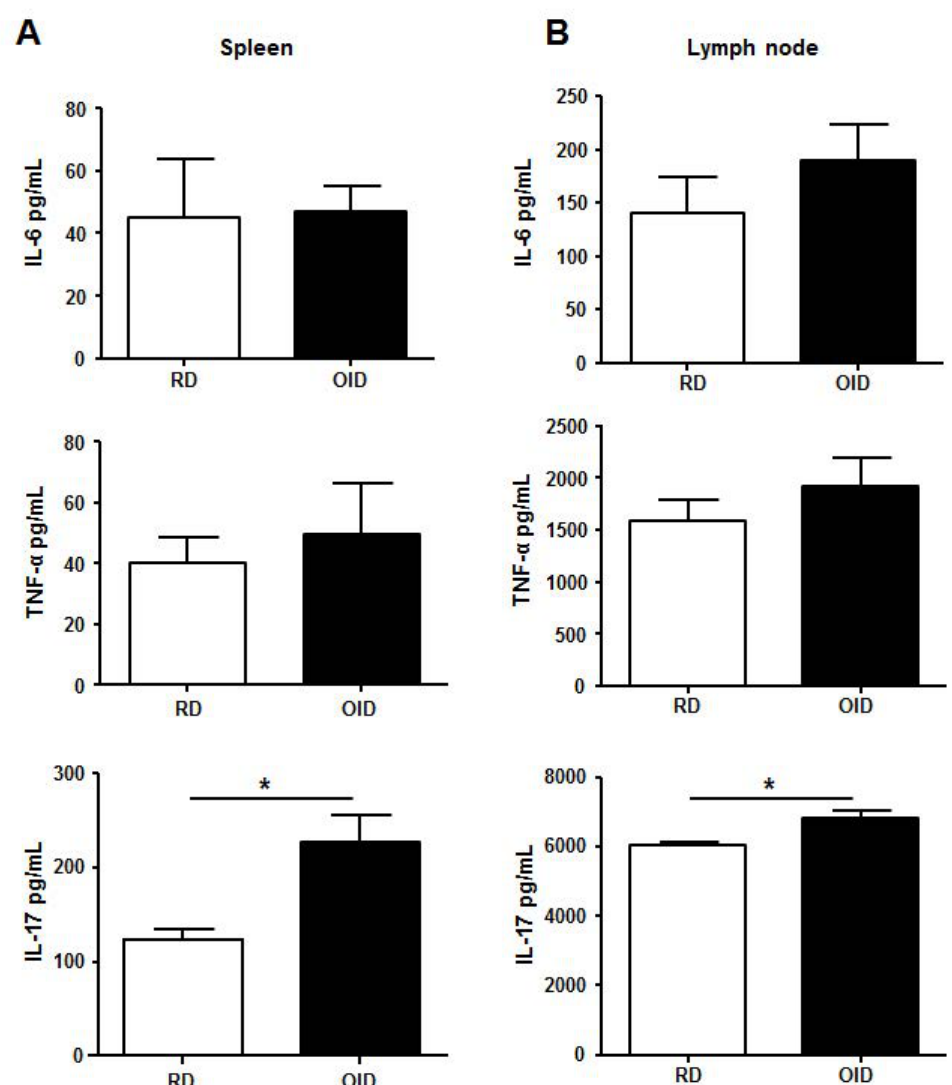
Figure 4. Level of cytokines (IL-17, IL-6, and TNF- α ) secretions from spleen ( A ) and lymph node ( B ) in imiquimod-treated mice reared on obesity-inducing diet (OID) or regular diet (RD) ( n = 4–6/group). The cytokines were measured in the cellular supernatants after stimulating the cells with anti-CD3 and anti-CD28 for 72 h. Data are represented as the mean cytokine level ± SEM. * p < 0.05. Results are representative of two independently performed